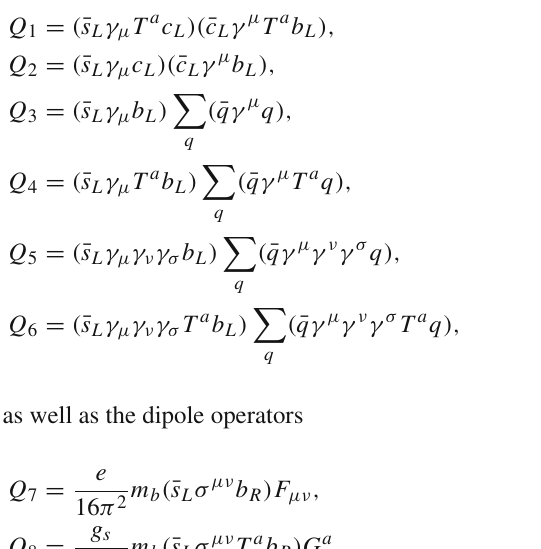
processes considered here are the four-fermion